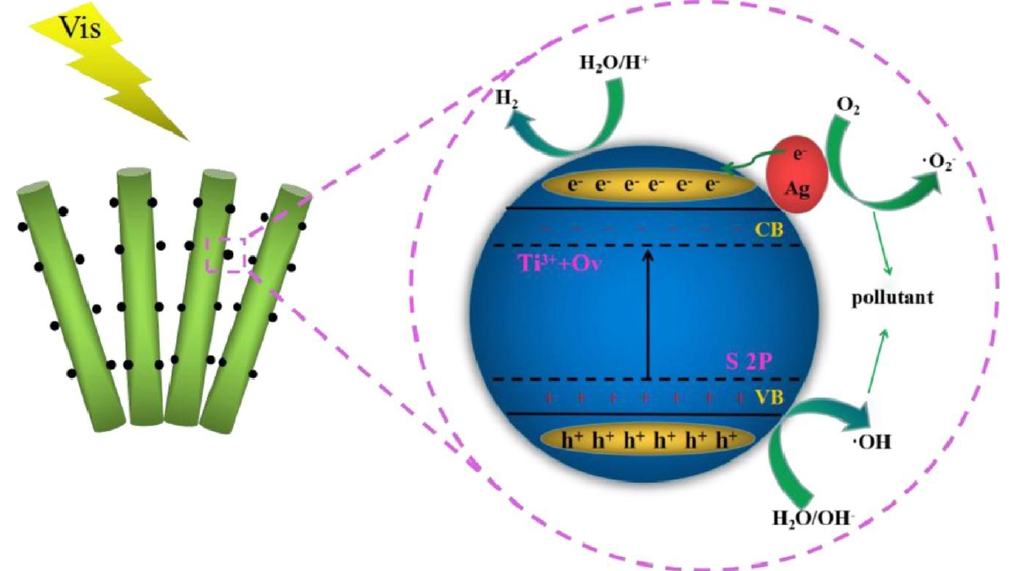
Figure 9. Schematic diagram for the formation of Ag/S–TiO 2−x nanorods. Reproduced from [133]. Copyright (2017), Elsevier.